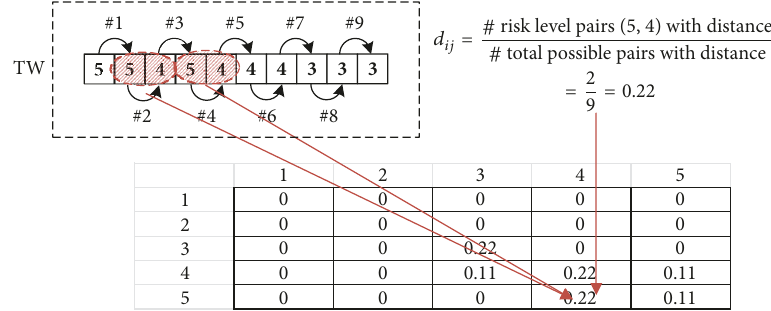
Figure 4: Calculation of risk level cooccurrence matrix.